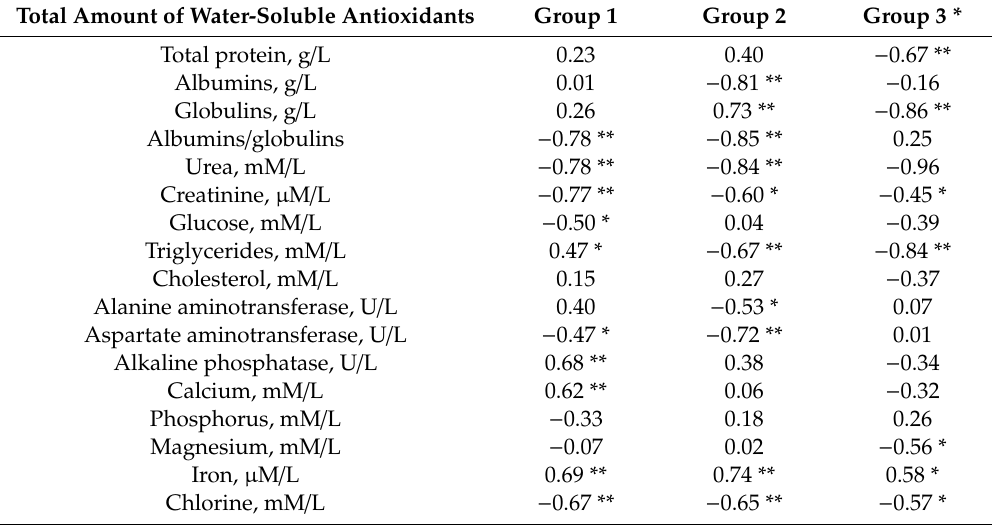
Table 5. Correlation coe ffi cients between the TAWSA and the major biochemical parameters of a blood serum of rumen-fistulated ewes.